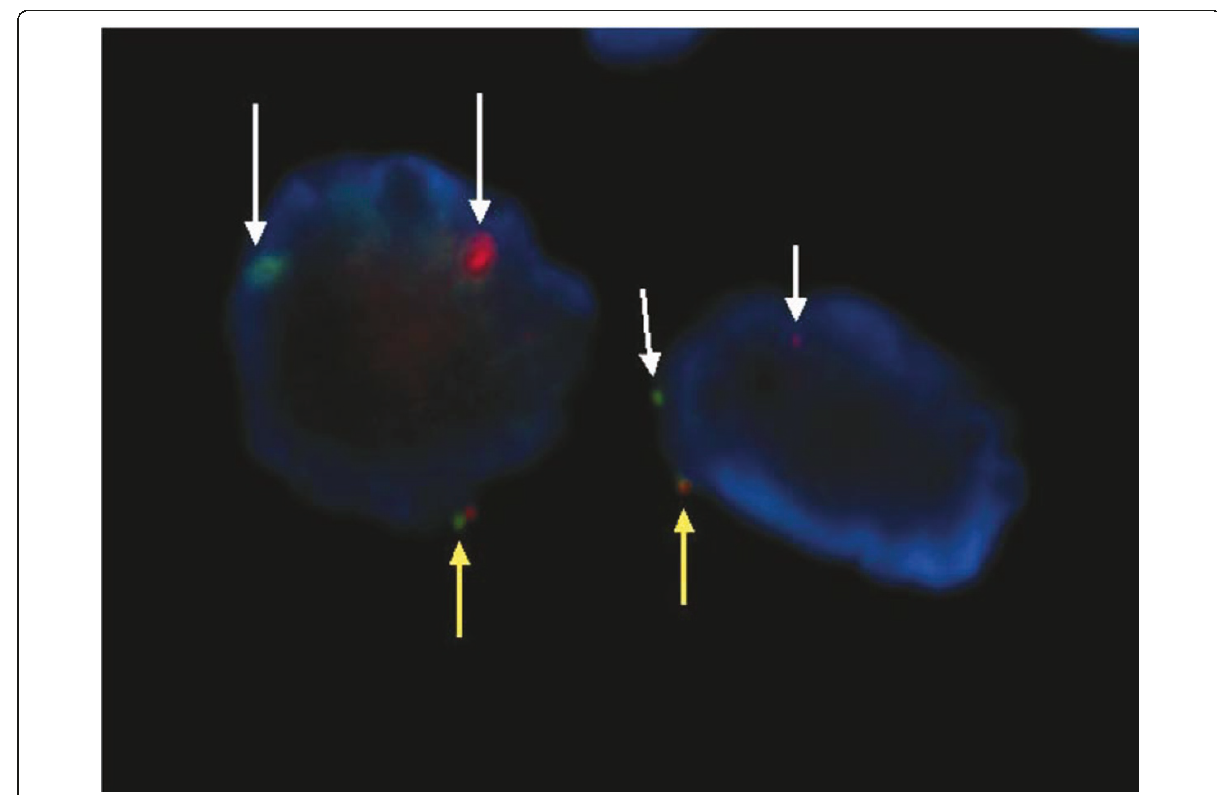
Figure 4 FISH analysis of the high grade component of the submandibular lymph node biopsy specimen showed the presence of one fused signal (yellow arrows) and two split signal (white arrows) in single cell, indicating the presence of translocation of MYC .